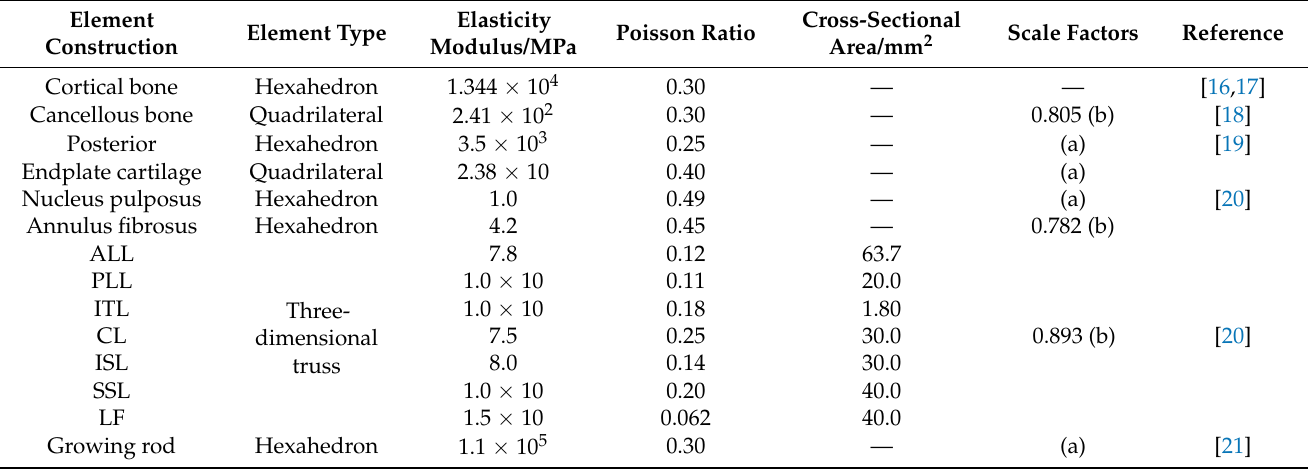
Table 1. Material properties in the present finite element